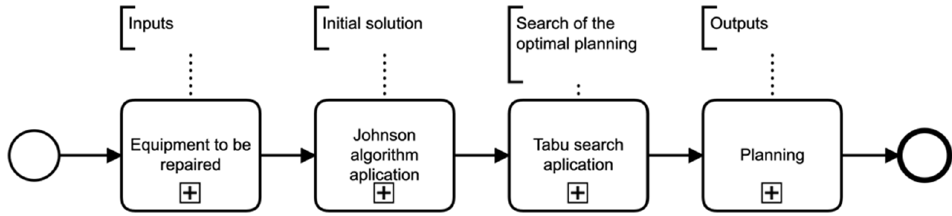
Figure 2. Stages considered in obtaining the